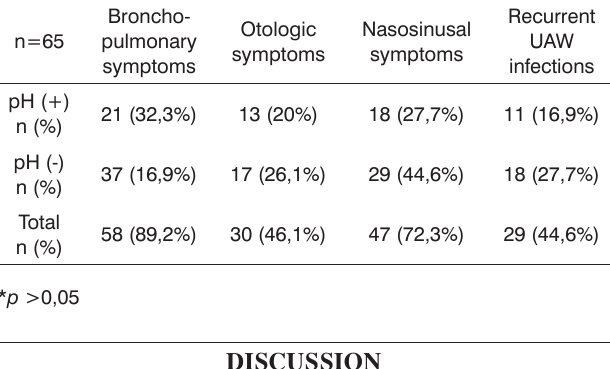
Table 4. Presence of bronchopulmonary symptoms, otologic symptoms, nasosinusal symptoms, recurrent UAW infections in the children who were studied, and their association with the pH probe